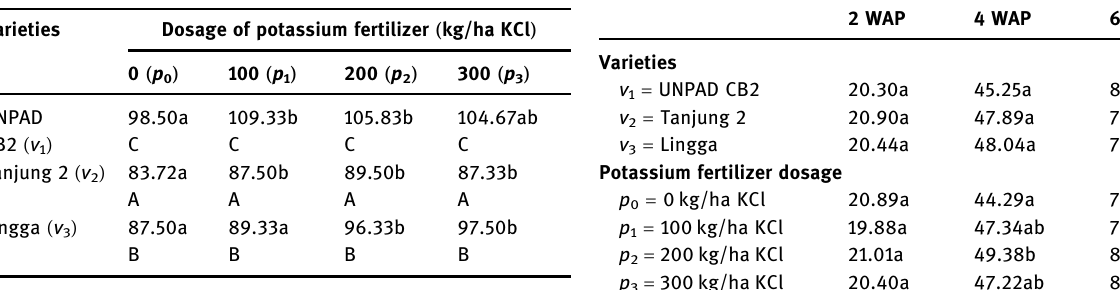
Table 1: E ff ect of interaction between dosage of potassium fertilizer and red chili varieties on plant height at 8 WAP